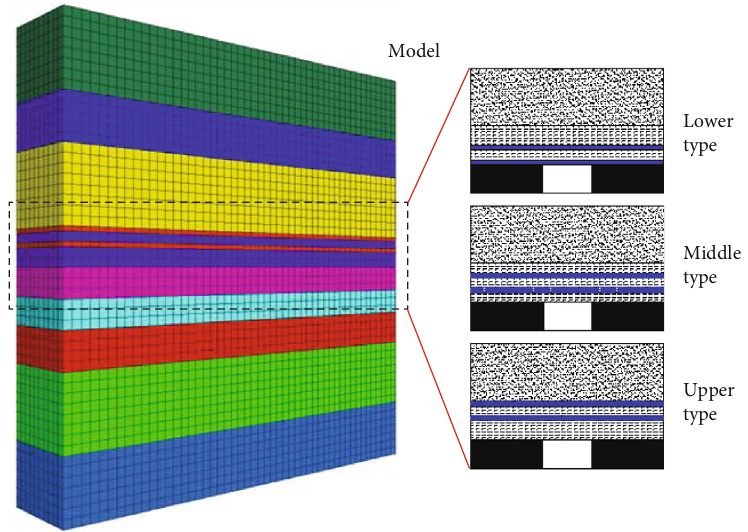
Figure 2: Composite roof models with di ff erent structures.